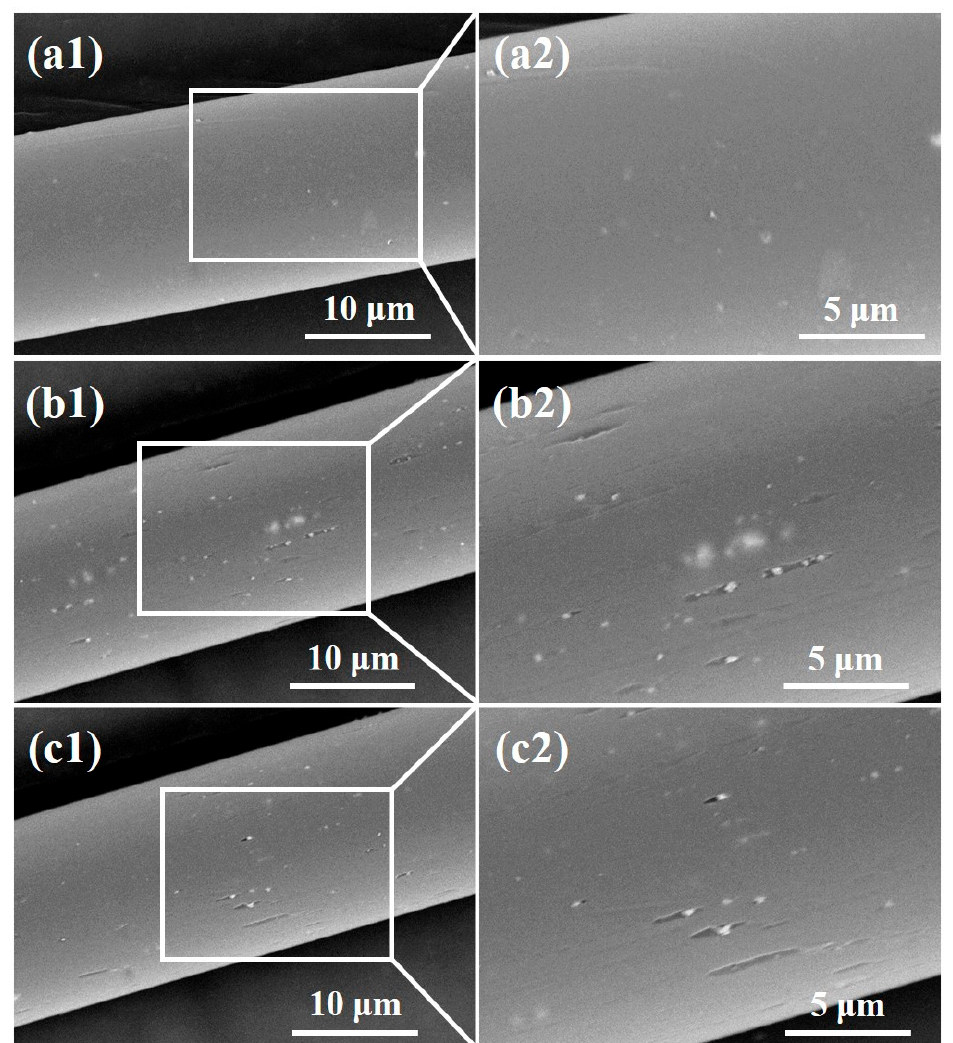
Figure 4. SEM images of the polyester fiber surface ( a ) before and after ( b ) oxygen, ( c ) helium plasma treatments.